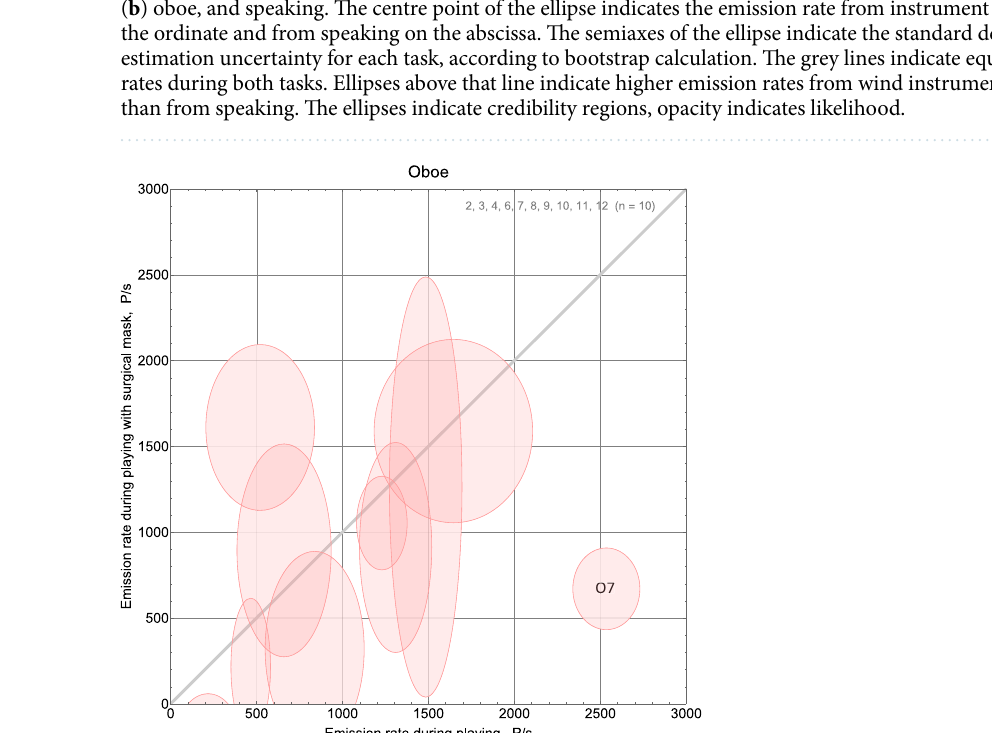
Figure 6. Aerosol emission rates for oboe playing with and without a surgical mask around the bell. Only proband O7 shows essential reduction in aerosol emission when playing with a surgical mask. The grey line indicates equal emission rates during both